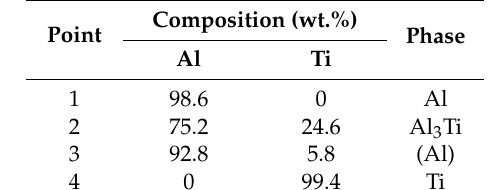
Table 4. Compositions of the sample points after remelting at 640 ˝ C for 8 h. Composition (wt.%) Point